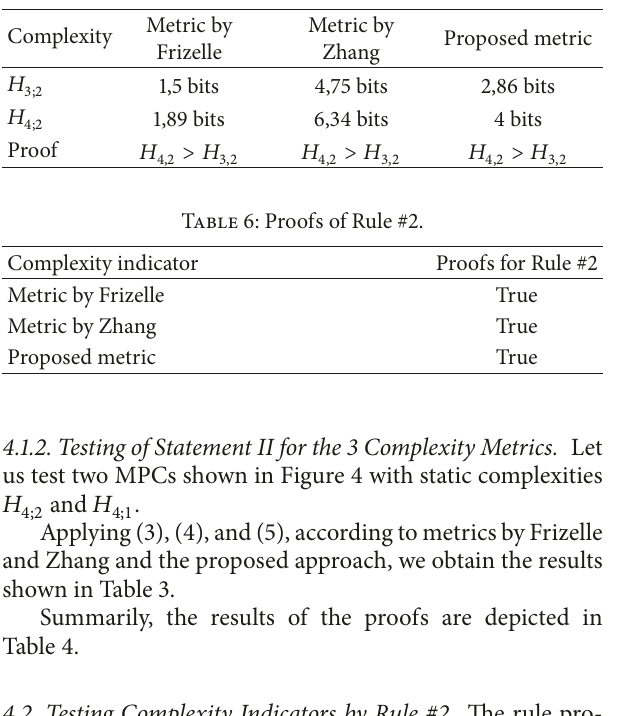
Table 5: Static complexity values and their proof.